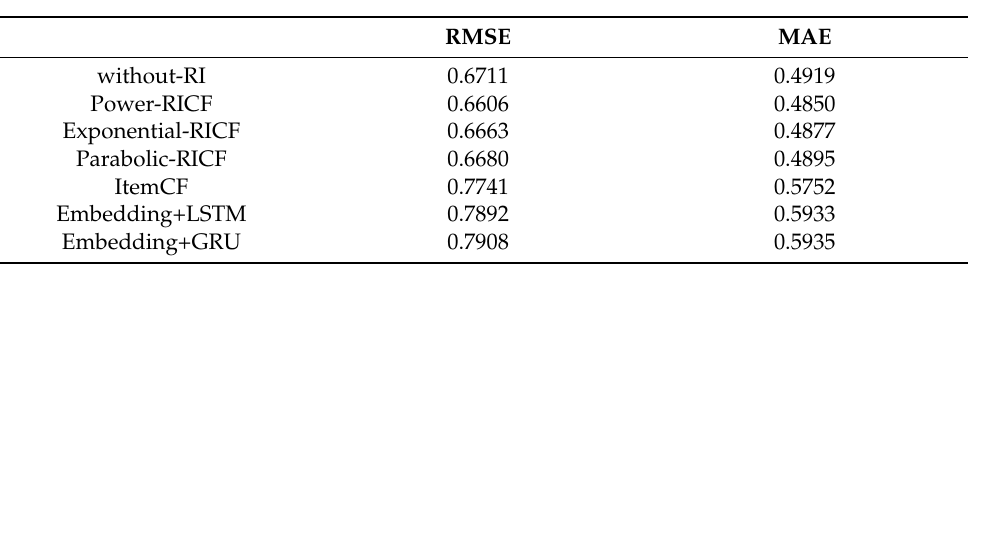
Table 4. RMSE of different comparative experiments on the MovieTweetings-100k dataset. RMSE